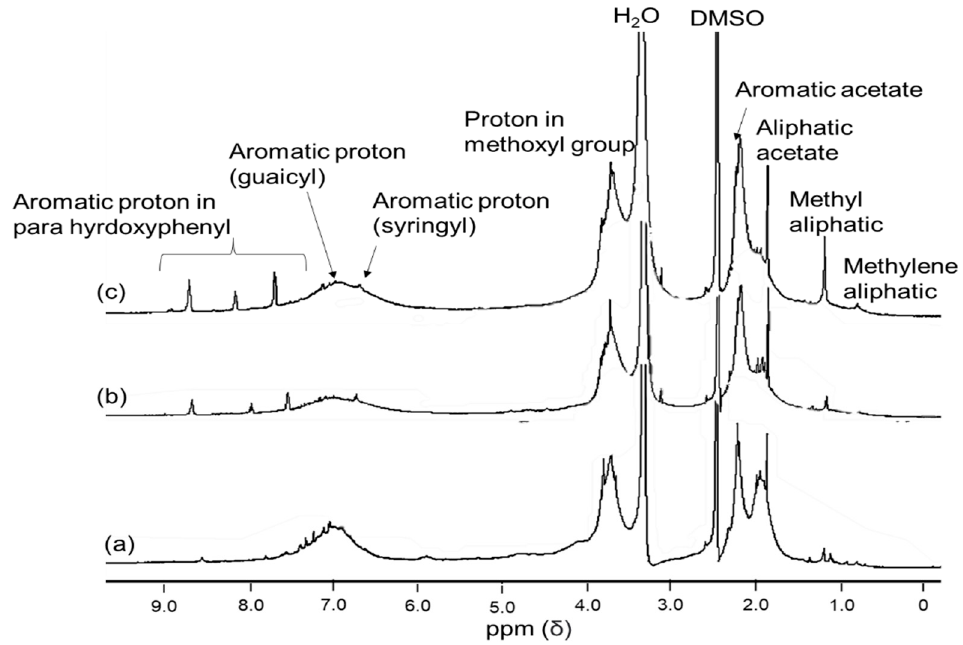
Figure 4. 1 H NMR signal of standard lignin ( a ), single-step lignin ( b ), and fractionated-step lignin ( c